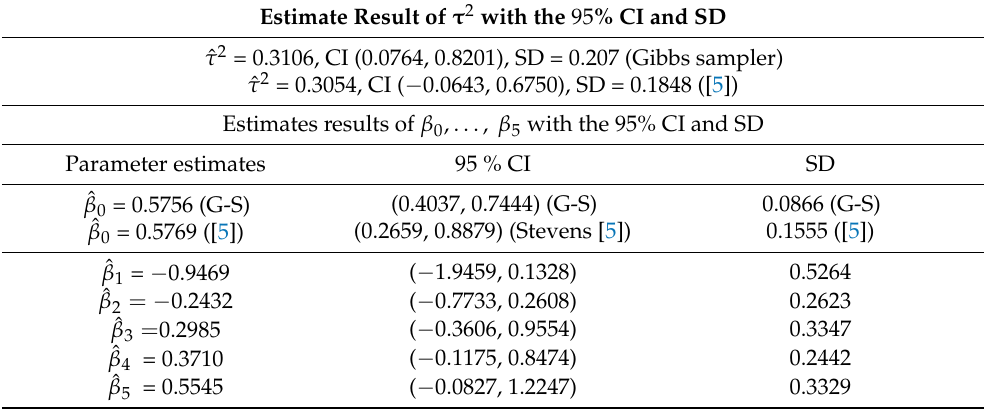
Table 5. Parameter estimates for the HBLD model using the Gibbs sampler for the case study. Estimate Result of  (cid:2779) with the 95% CI and SD  (cid:3548) (cid:2870) = 0.3106, CI (0.0764, 0.8201), SD = 0.207 (Gibbs sampler)  (cid:3548) (cid:2870) = 0.3054, CI (−0.0643, 0.6750), SD = 0.1848 ([5])